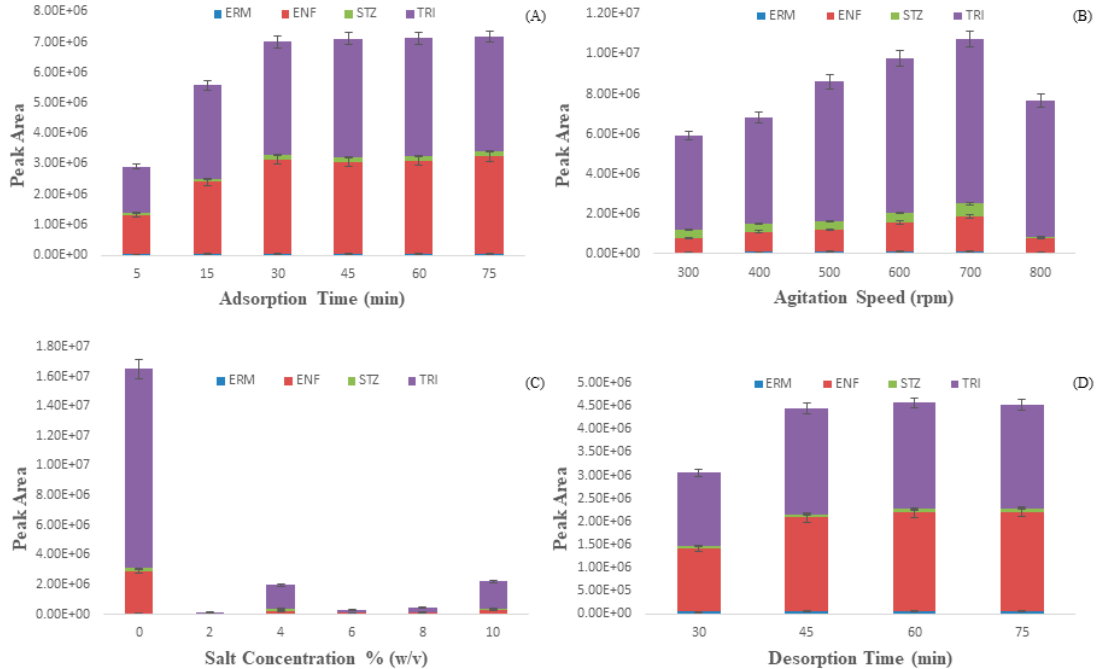
Figure 5. Effect of ( A ) extraction time (min), ( B ) agitation speed (rpm), ( C ) salt conc.% ( w / v ) and ( D ) desorption time to extract Antibiotics from water.